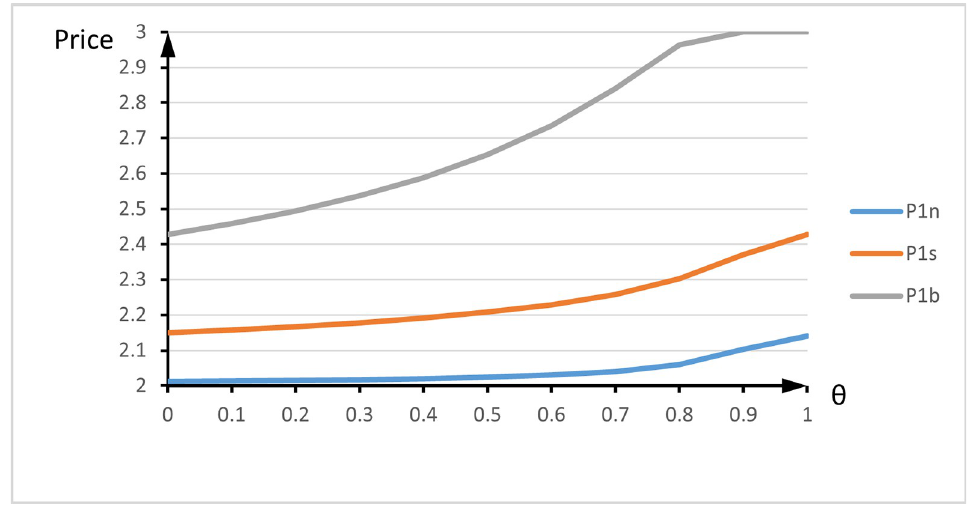
Fig 2. The influence of new high-type customers number on optimal pre-order price for different trade-in strategies. is the seller’s expected total profit under different trade-in strategies. The grey curve represents the seller’s expected total profit π n with just advance selling no trade-in strategy, the orange curve represents the seller’s expected total profit π s with advance selling and just trade-in strat- egy in second period, and the blue curve represents the seller’s expected total profit π b with advance selling and trade-in strategy in both periods. Fig 3 shows that the profits of three trade-in strategies always strictly increase with θ . The two trade-in strategies are much better than no trade-in strategy for any θ , so either trade-in strategy is always optimal for the seller because the seller can set a higher pre-order price with a higher value demand. It is also noted that there exists a threshold value of θ 0 which is the intersection of the two profit curves of strategy 2 and strategy 3, and the profit is the same as θ = θ 0 . The profit of strategy 3 is greater than strategy 2 as θ < θ 0 , and the profit of strategy 2 is greater than that of strategy 3 as θ > θ 0 . This means more new high-type customers do not always benefit the seller under strategy 3.